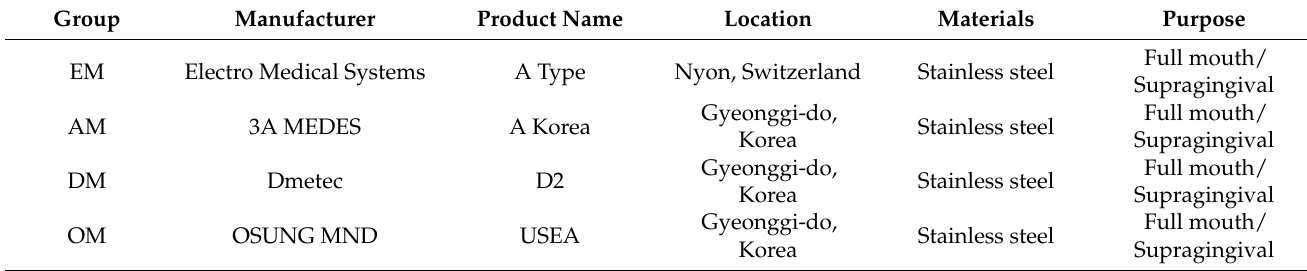
Figure 1. Four commercial stainless steel ultrasonic scaler tips used in the study and produced by ( A ) Electro Medical Systems, ( B ) 3A MEDES, ( C ) DMETEC and ( D ) OSUNG MND. Table 1. The four commercial stainless-steel ultrasonic scaler tips used in this study.